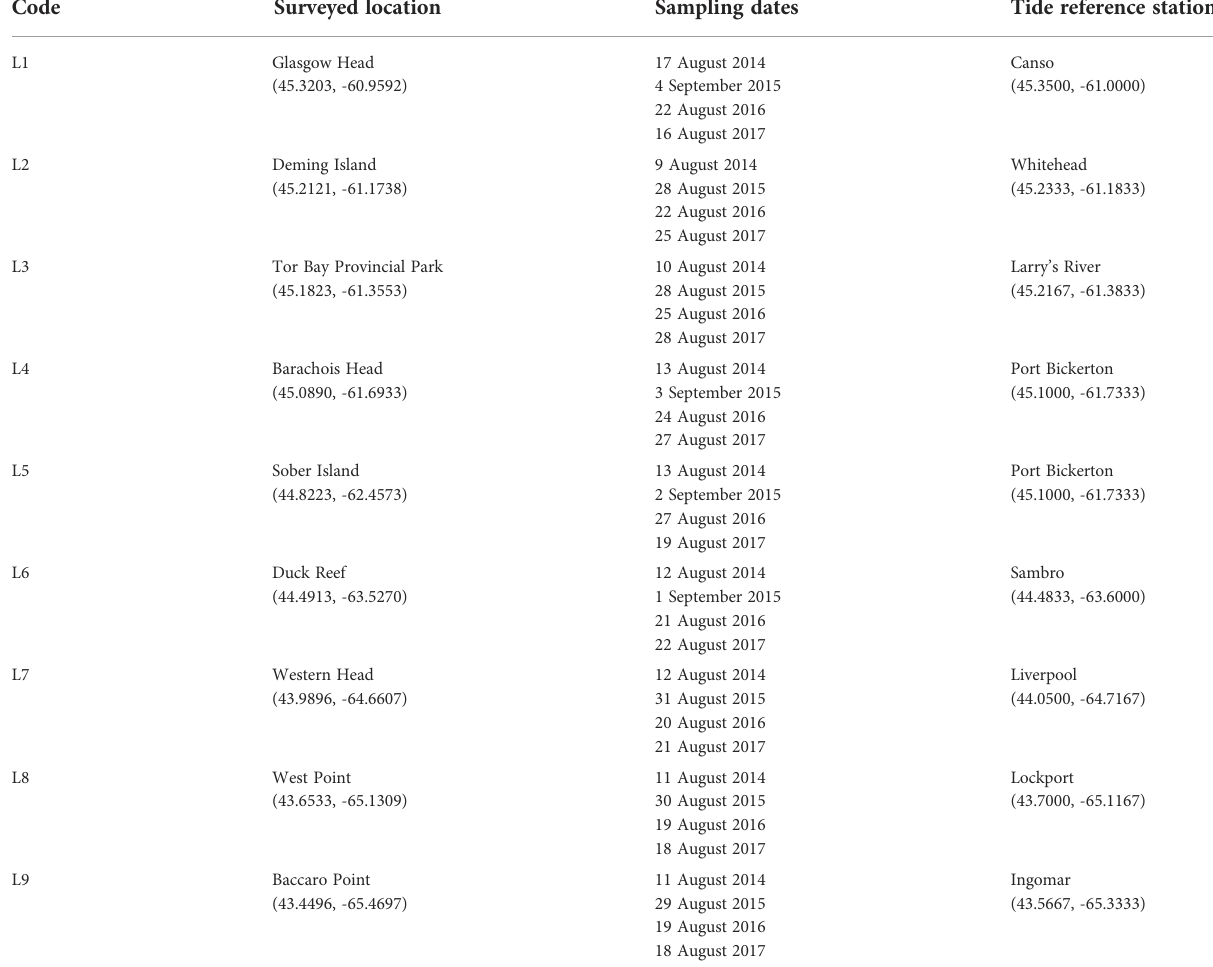
TABLE 1 Names of the surveyed locations (with geographic coordinates in parenthesis), sampling dates when species abundance was measured, and names of the tide reference stations (with geographic coordinates in parenthesis) that are closest to the surveyed locations.